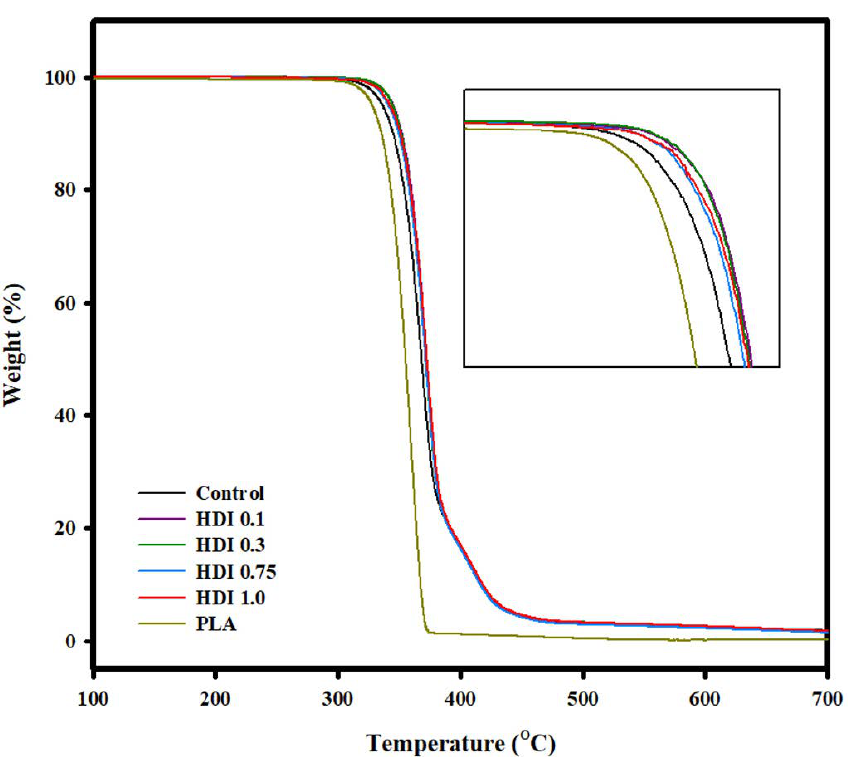
Figure 7. ( a ) TGA and curves of PLA and PLA/PBSeT blends prepared with various HDI contents. Figure 7. TGA and curves of PLA and PLA/PBSeT blends prepared with various HDI